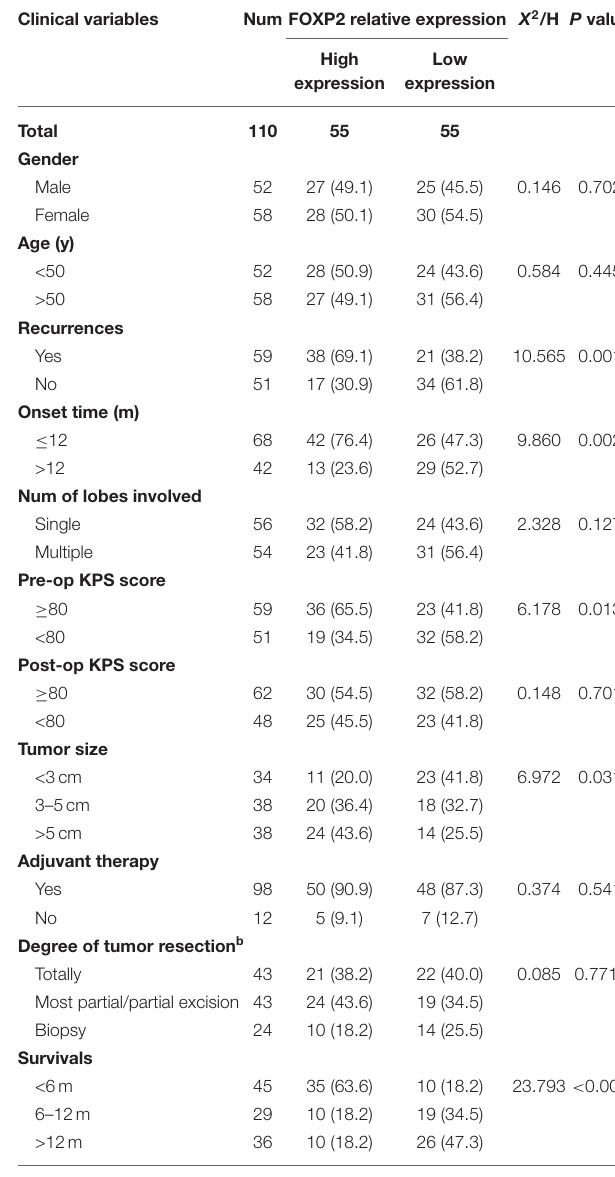
TABLE 2 | Clinical features and relative expression of FOXP2 in glioblastoma (110